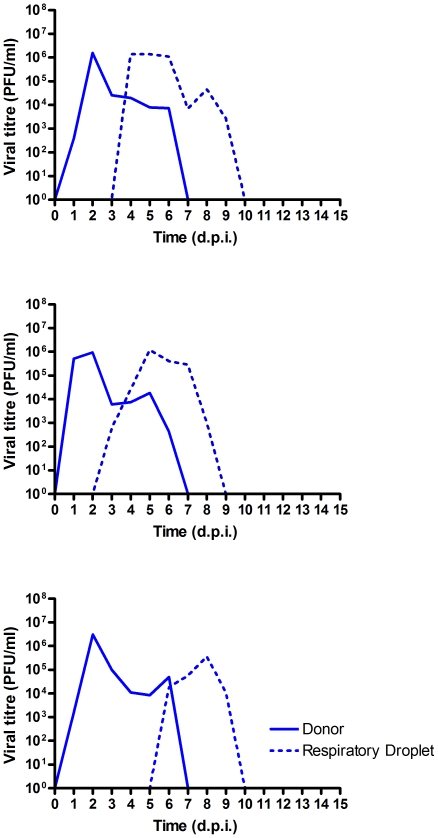
Transmission of wild type E195 in ferrets in respiratory droplet sentinels.Viral titres in nasal wash samples of ferret pairs, each pair contained one donor (solid lines) and one respiratory droplet (dotted lines). Donors were inoculated with 103 PFU E195. Samples were taken daily and viral titres were determined by standard plaque assay on MDCK cells.